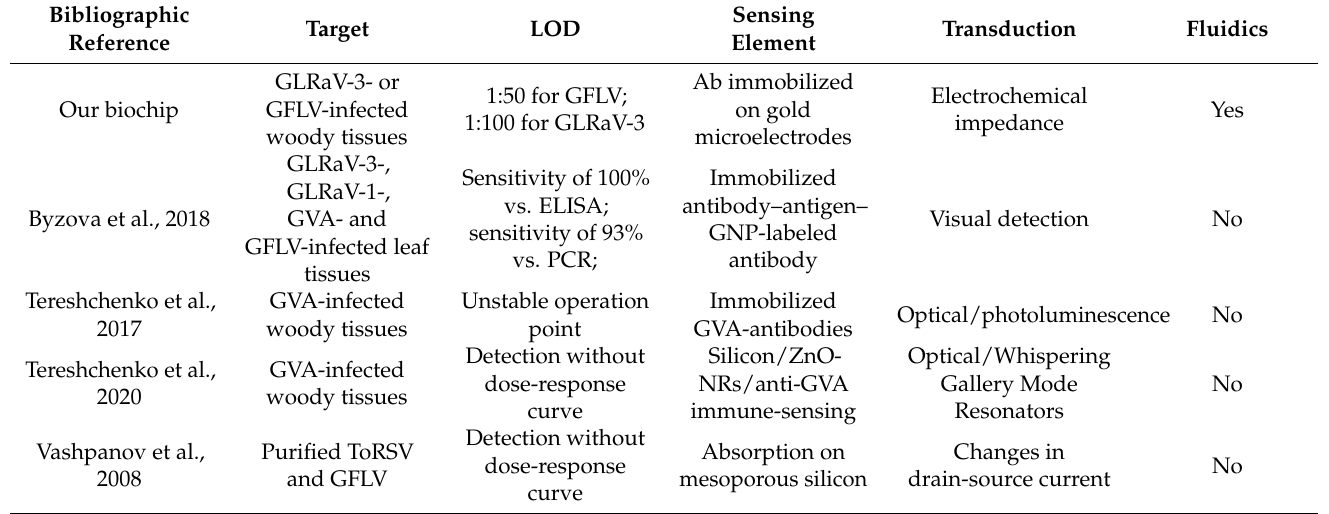
Table 2. Comparison of operative conditions and performance among our biochip and the present literature on biosensors for grapevine pathogens detection.